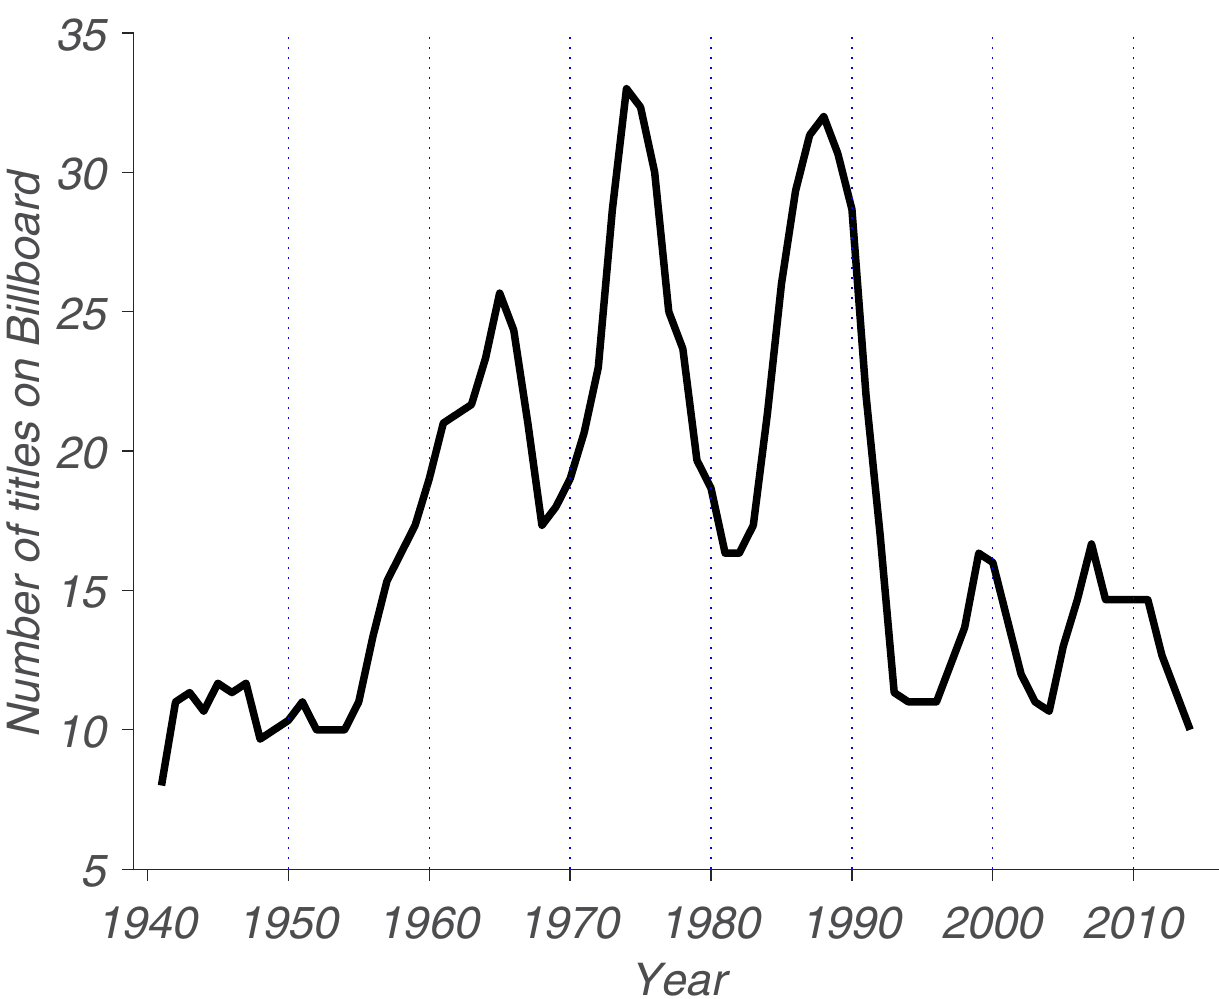
Fig 5. Diversity of music over time. Note that the data was smoothed by a 3-year moving average. A value of just above 10 in the early 1940s means that an average song was at the top of the charts for over 4 weeks in a row. The peak levels in the mid-1970s mean that the average song was only on top of the charts for little more than a week during that